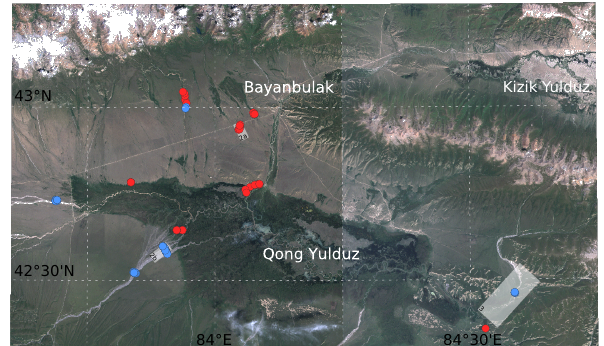
Figure 1. Definitions involved in the morphology of meandering (left) and braided (right) rivers (Métivier and Barrier, 2012).